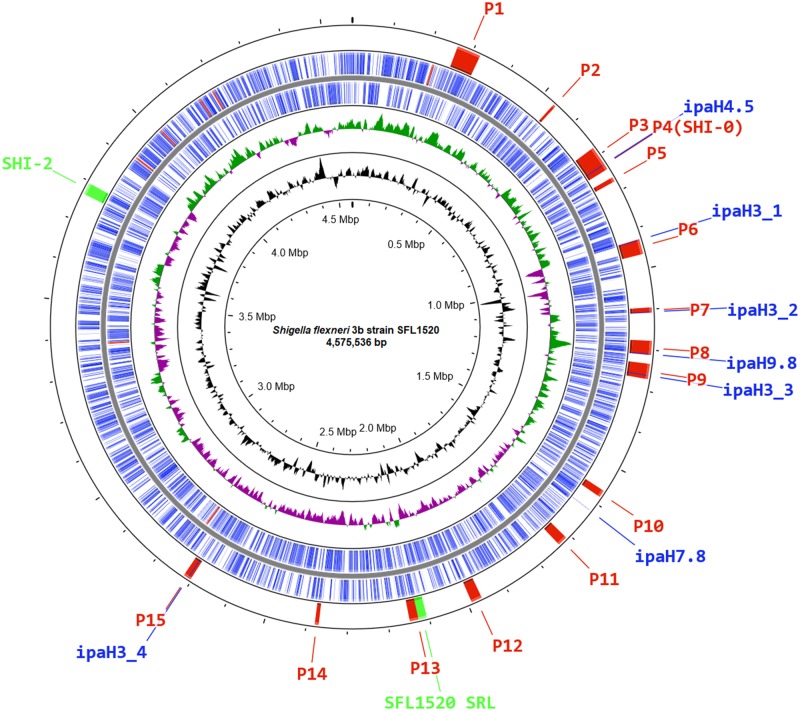
—Schematic circular genome map of S. flexneri 3b strain SFL1520. The outermost ring shows the location of bacteriophage regions (P1–P15; red), SFL1520 SRL and SHI-2 (Green) and ipaH genes (Blue). The second and third rings depict ORFs of SFL1520 encoded by leading and lagging strands with color codes: CDS (blue) and rRNA (red). The green and purple colors in the fourth ring denote the positive and negative GC skew (G–C/G+C), respectively. The fifth ring in black shows the deviation from average percentage GC content. The innermost ring represents the nucleotide position in the genome.